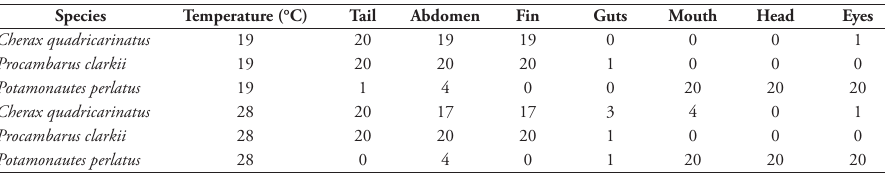
Table 4. Proportion of fish with different categories of damage i